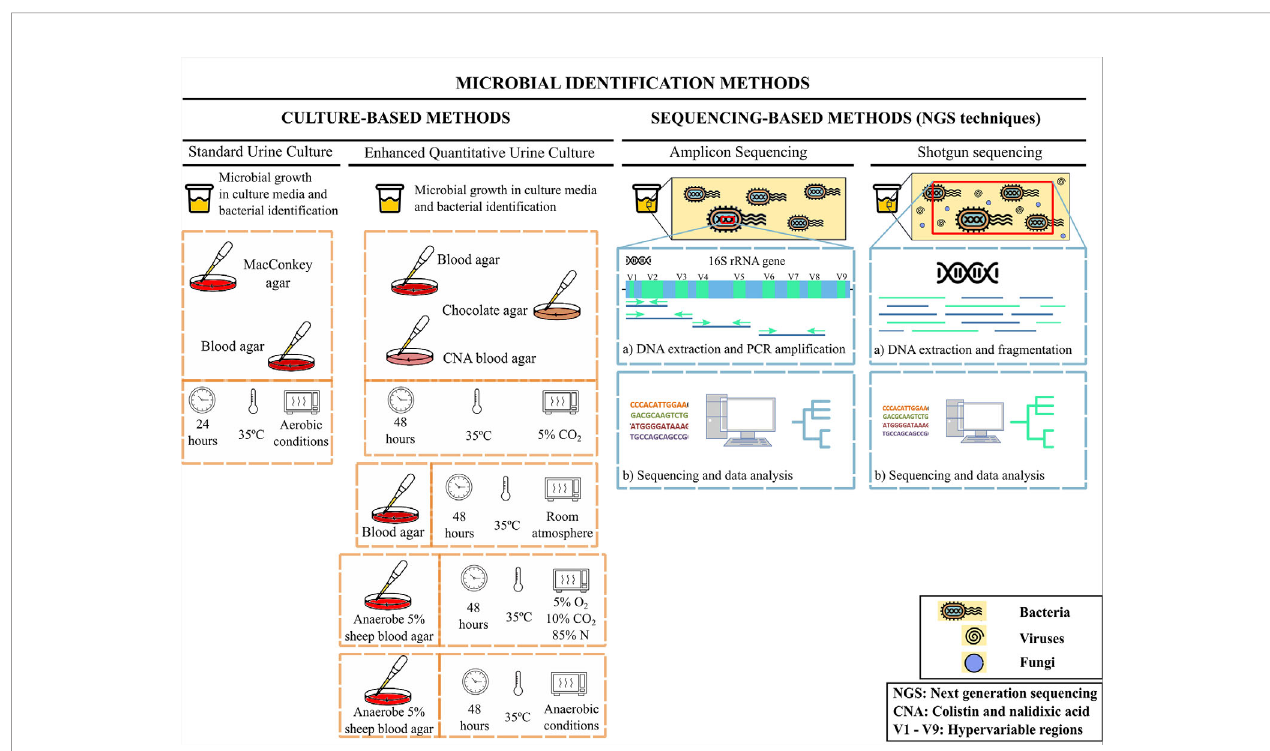
FIGURE 1 | Microbial identi fi cation methods for urine samples. Bacteria in urine samples can be identi fi ed by different methods: culture-based methods (standard urine culture or enhanced quantitative urine culture (EQUC)) or sequencing-based methods (amplicon sequencing or shotgun